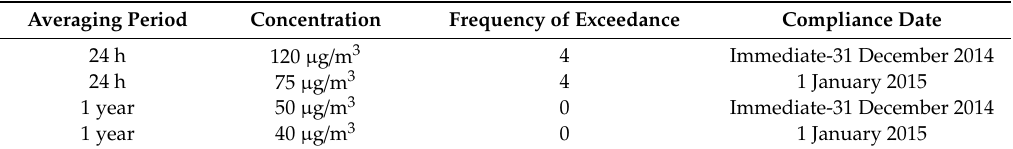
Table A3. National Ambient Air Quality Standard for Particulate Matter (PM 10 ).